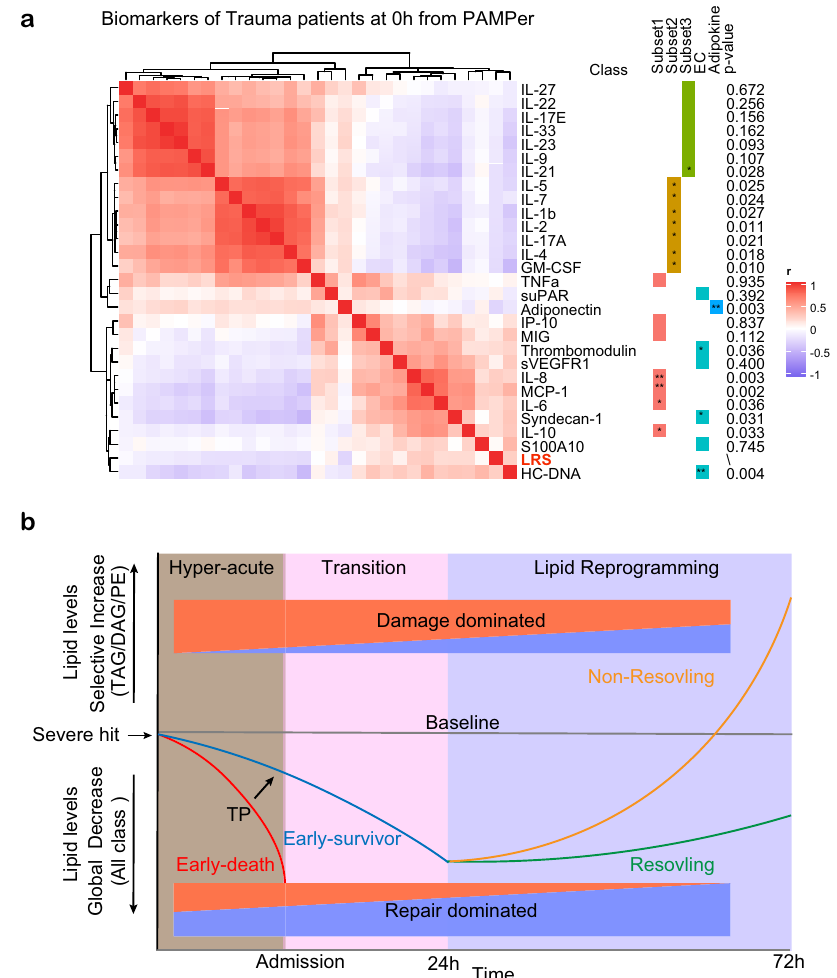
b Schematic of proposed paradigm showing the relationship between circulating lipid levels and outcomes after severe injury. Early loss of circulating lipids corre- lateswithadverseoutcomeswhilefailuretoresolvecriticalillnessisassociatedwith the selective increase in glycerolipids and